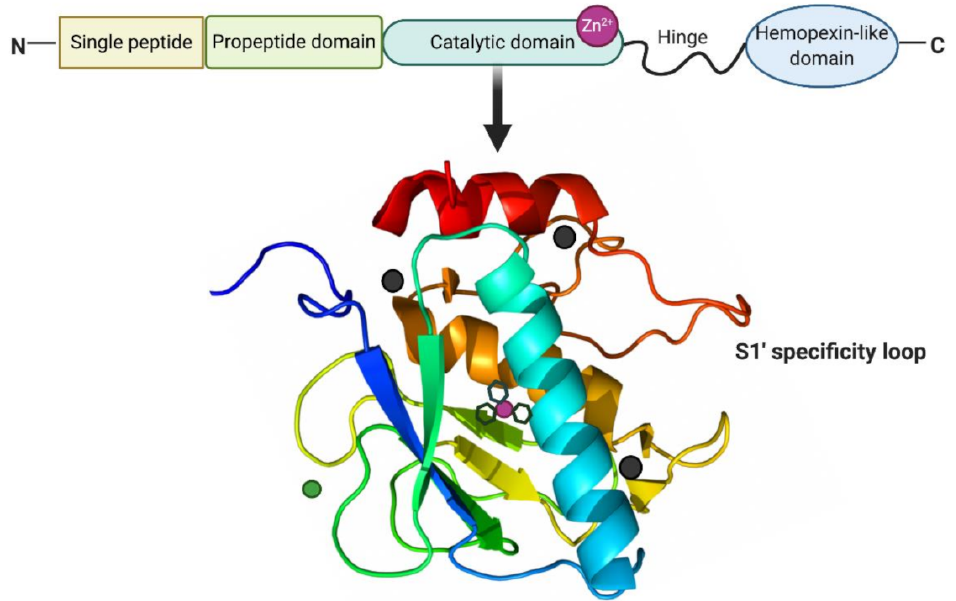
Figure 2. Structure of MMP-13. MMP-13 typically consists of a highly conserved signal peptide, a propeptide domain, a catalytic domain, a proline-rich hinge region, and a C-terminal hemopexin-like domain. The catalytic domain of MMP-13 is represented by the crystal structure. The structural zinc ion is in green, the catalytic zinc ion is in magenta, and three calcium ions are in dark grey. Three histidine residues in black sticks coordinate the catalytic zinc ion. The highly flexible S1 (cid:48) specificity loop as part of hydrophobic S1 (cid:48) pocket is a determining factor for the selective inhibitors of MMP-13. Created with